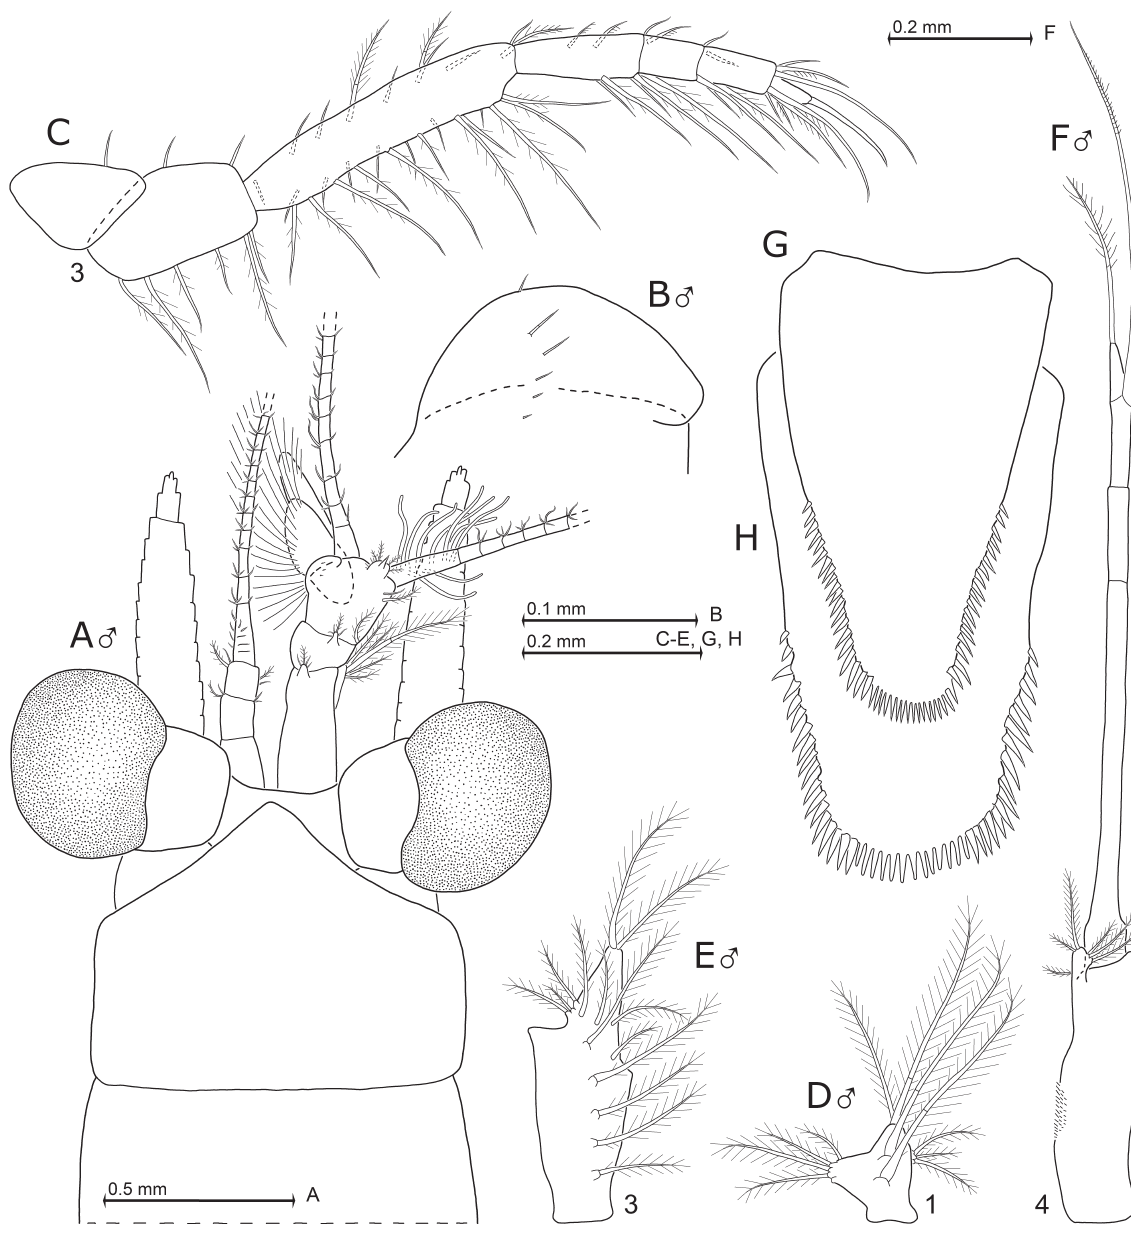
Fig. 2. Mysidium integrum W.M. Tattersall, 1951, from Curaçao (A–G) and off Cabo Frio in Brazil (H), non-types. A . ♂, 5.1 mm body length. B . ♂, 5.3 mm. C–G . ♂, 4.6 mm. H . ♂, 6.8 mm. A . Cephalic region; left antennula and setae of antennal scale omitted. B . Mediodistal extension of right antennular trunk, dorsal view. C . Third thoracic endopod, caudal view. D – E . Pleopods 1 and 3, rostral view. F . Pleopod 4, caudal view. G – H . Telson variants. Sample affiliation: Curaçao #C3 (A, C–G), #C9 (B); Brazil #F13